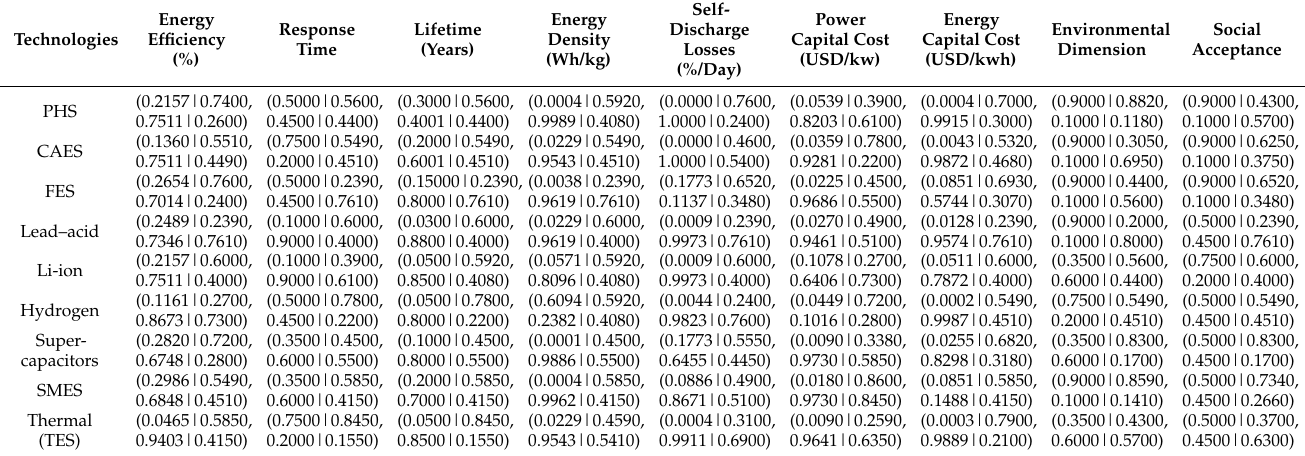
Table A6. Initial decision matric of Expert 4.